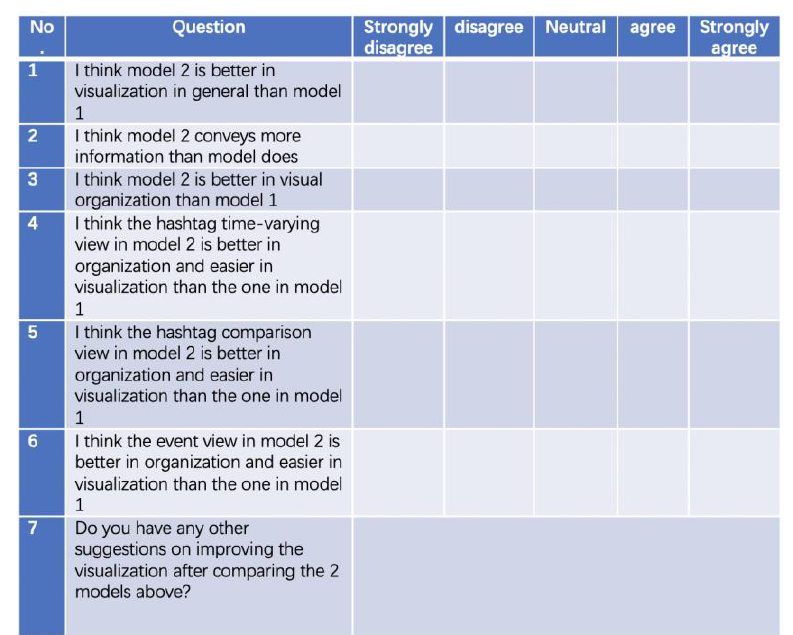
Figure 22 Brief overview of the questionnaire